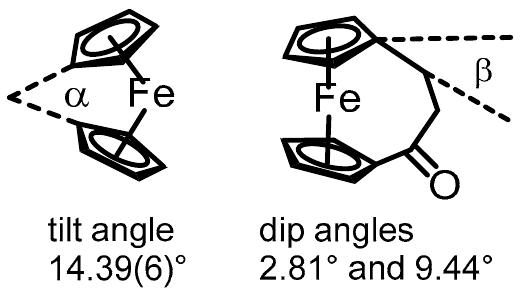
Figure 2. Geometric parameters. Table 1. Crystal Structure Refinement of 1 + SbF 6 .